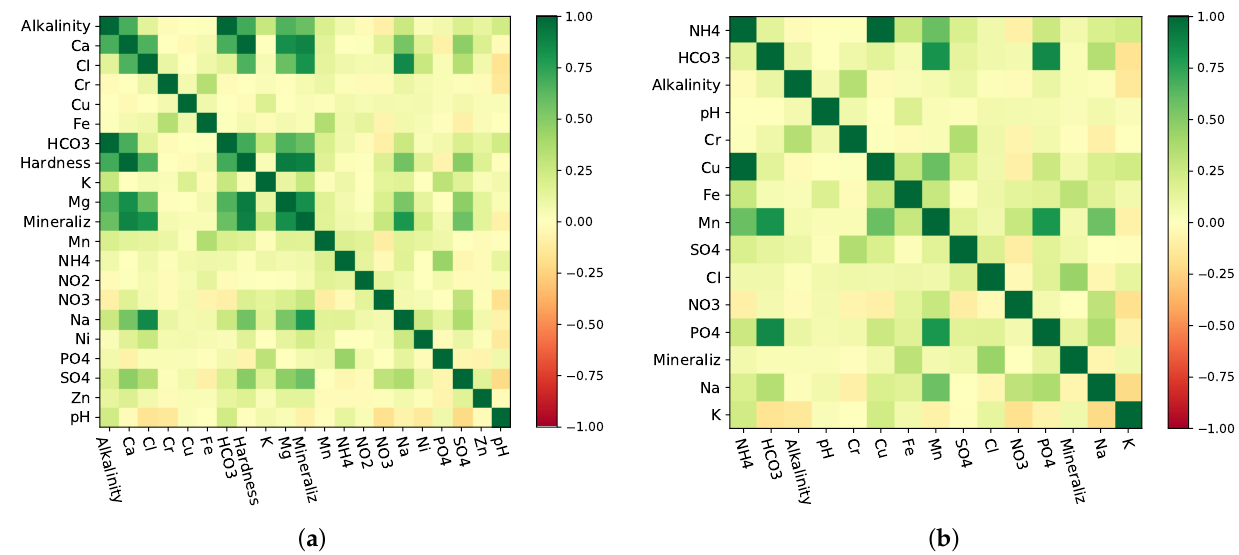
Figure 4. The correlation heatmap for chemical parameters in tested freshwater samples. Figure ( a ) present correlation coefficient) between all measured chemical parameters, while figure ( b ) present correlation coefficient only for parameters with significant PCA loading. Initial number of water quality parameters for WQI constriction was reduced from twenty-one to fifteen after